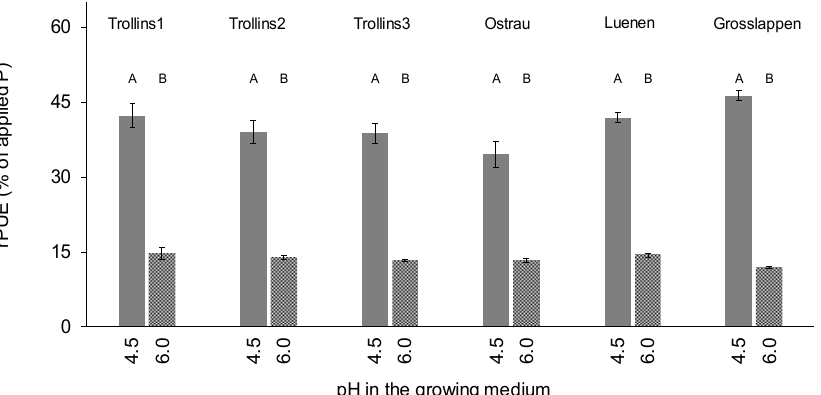
Figure 2. Relative phosphorus use efficiency (rPUE) at two contrasting pH levels in the growing medium for each sewage sludge ash (SSA). Different letters indicate differences between the pH levels for each SSA (Tukey, p < 0.001), and error bars indicate the standard error of mean (n = 4).